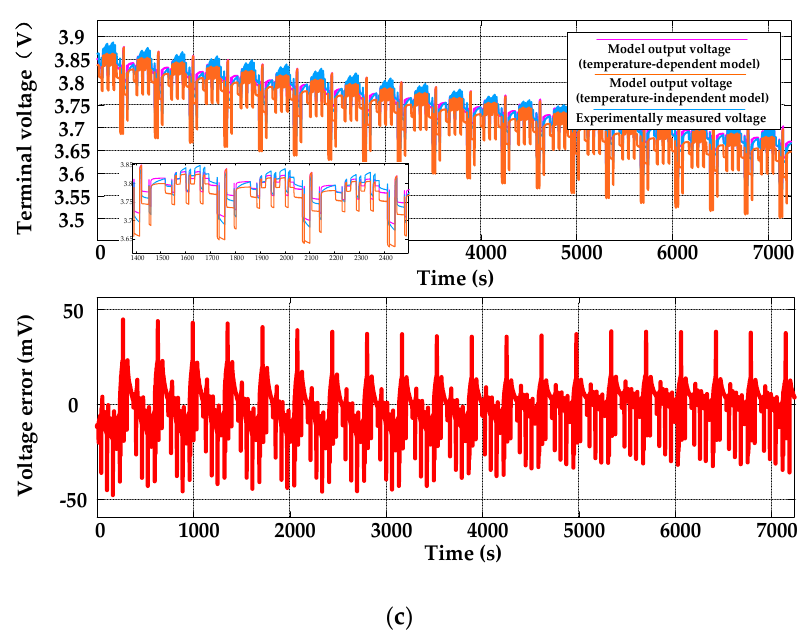
Figure 10. Model verification results under varying temperature conditions: ( a ) model output voltage and its error for the discharging test, ( b ) model output voltage and its error for the charging test, and ( c ) model output voltage and its error for the DST. The magnified mini-plot is an enlarged view for the time range of 1400 s–2400 s.